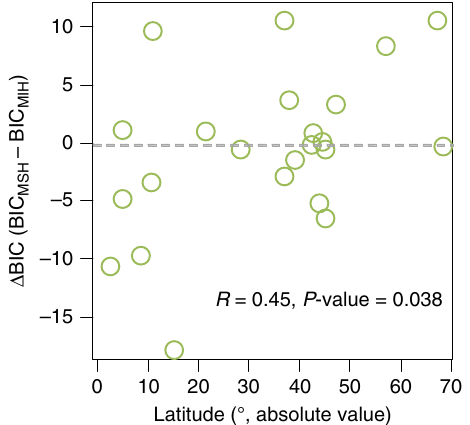
Fig. 3 The more species hypothesis is more likely towards low latitudes. Δ BIC (BIC – BIC MSH MIH ) is negatively correlated to Latitude expressed in absolute values ( R = 0.45, P -value = 0.038)). The dashed line represents the threshold above which the more individuals hypothesis (MIH) is more likely than the more species hypothesis (MSH); the opposite is true below the dashed line.